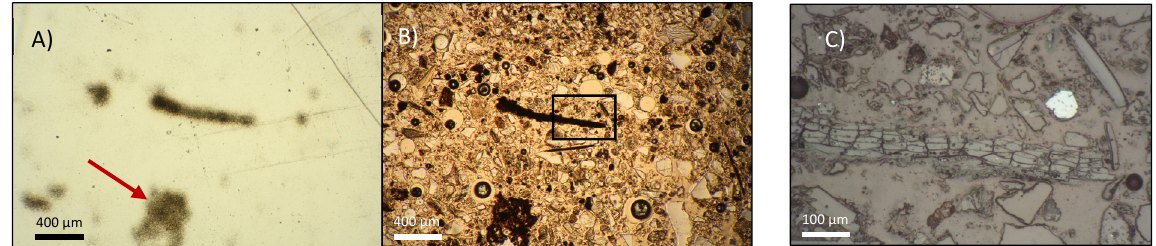
Figure 4. Fission-track and microscope images of sample GJAST − 15 − 13 (Figure 2). ( A ) Fission track image at 2.5X mag- nifcation. ( B ) Thin section in plain light of the same area at 2.5X magnification. ( C ) Thin section in reflected light at 10X magnification at the box located in ( B ) showing cell structure. Red arrow points to a high fission track particle where the cell/mineral structure could not be identified.